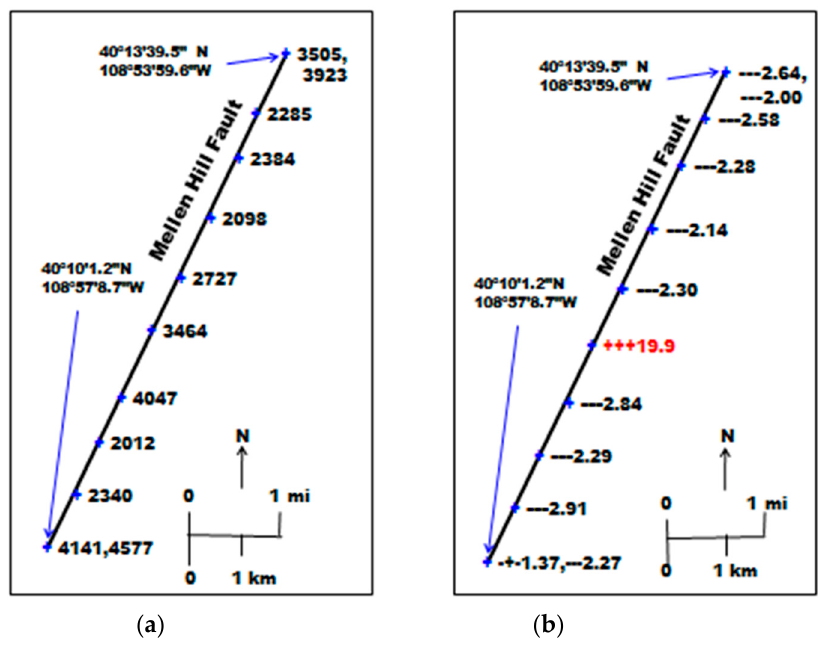
Figure 4. Soil gas concentrations, ( a ) CO 2 concentration (ppmv), ( b ) relative δ 13 C of CO 2 compared to atmospheric δ 13 C, and CH 4 concentration (ppmv) along the Mellen Hill Fault.